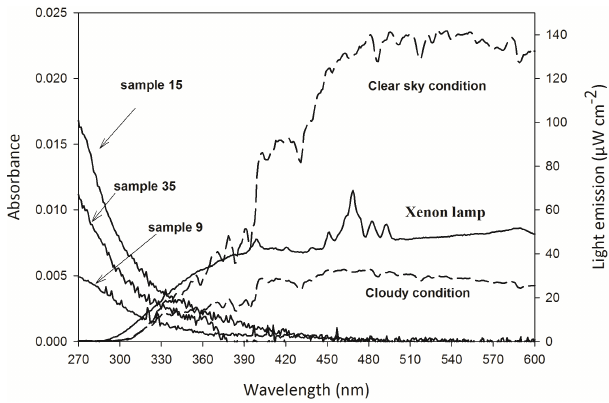
Figure 1. Absorption spectra of different cloud water samples on the left axis; the right axis shows the emission spectrum of the adopted xenon lamp reaching solutions over the range of 290– 600nm (total flux intensity = 157Wm − 2 ) compared with the sun emission spectrum (dashed line) for a sunny (353Wm − 2 ) and a cloudy day (90Wm − 2 ) in October